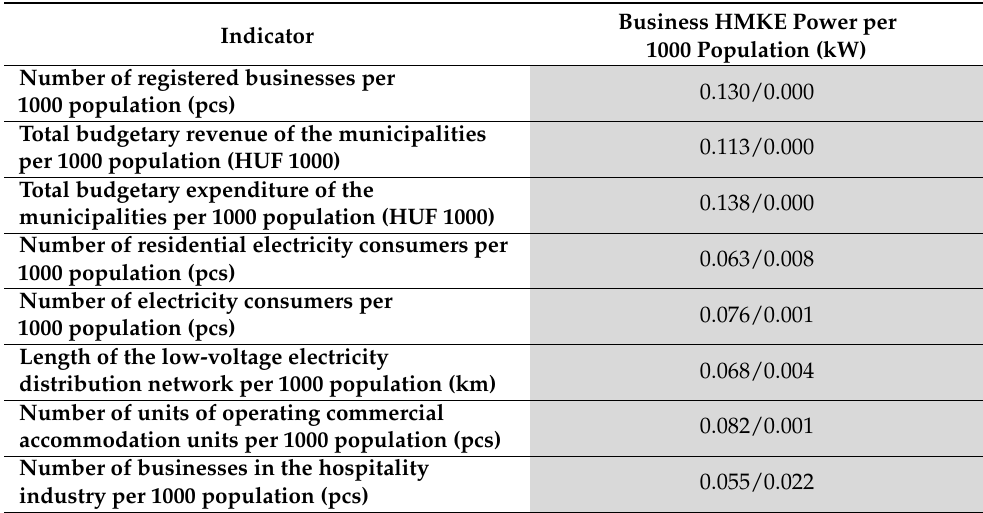
Table A10. The strengths of the relationships between the power of the business HMKEs per 1000 population and the settlement indicators 1 ( 1 Pearson correlation coefficient/ p -value; if p < 0.05, then there is a significant verified relationship between the two variables) (In the case of the Pearson correlation coefficients in the table grey background indicates weak